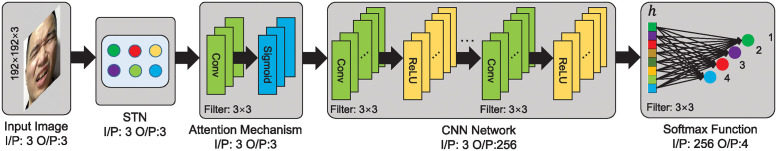
The architecture of the proposed pain intensity estimation method, where I/P and O/P denote the channel number of input and output feature maps, respectively.In the proposed method, the input face image is first fed into STN to against background interference; then, the attention mechanism is used to adaptively distribute different face region weights; finally, the attentional face image is input to CNN module and Softmax Function to extract features and classify pain levels.